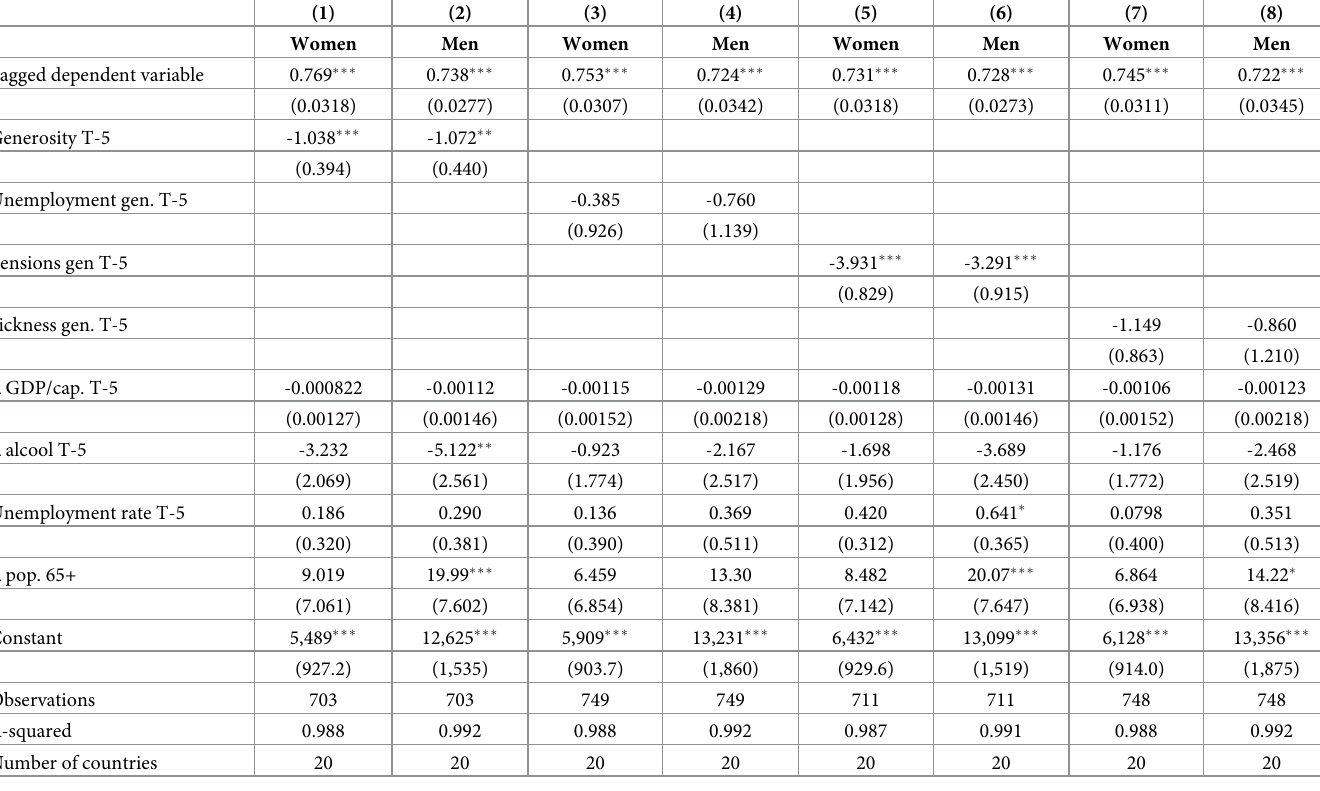
Table 1. Relationships between the generosity index and the age-standardized death rate, with country fixed effects and country specific time